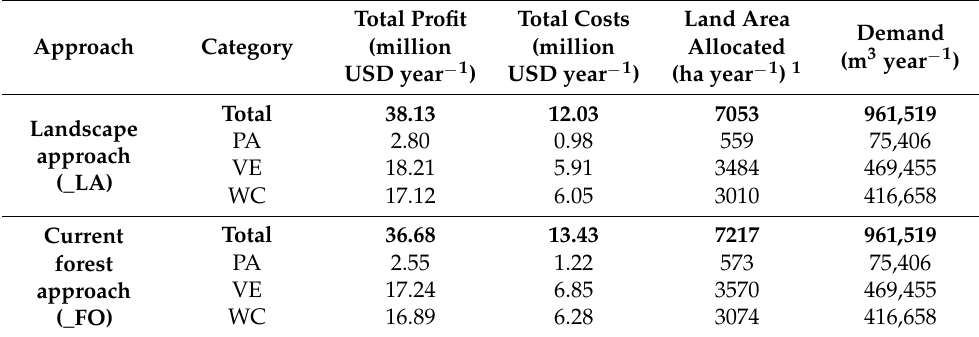
Table 4. Key statistics for the landscape approach and the current forest approach (PA: pallet mills, VE: veneer mills, WC: woodchip